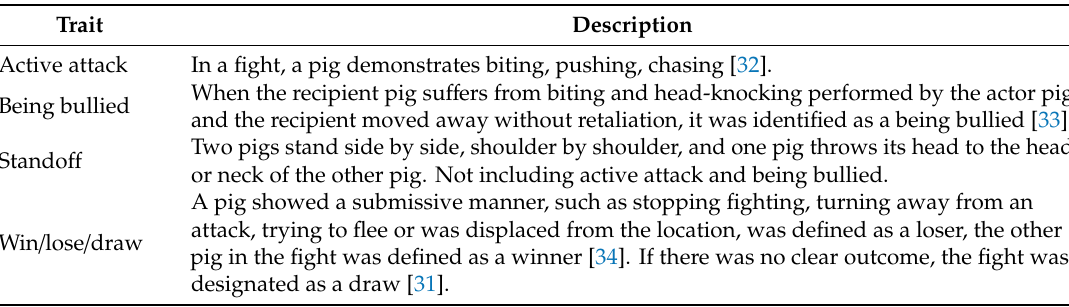
Table 1. Description of dyadic behavioral